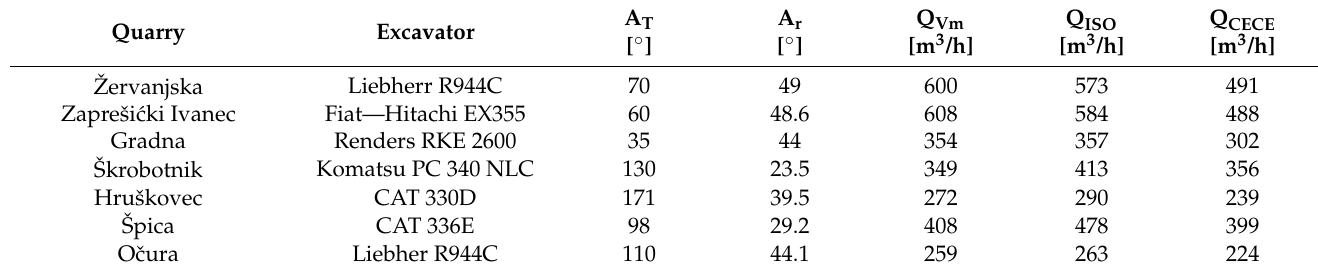
Table 4. Comparison of the excavator productivity.